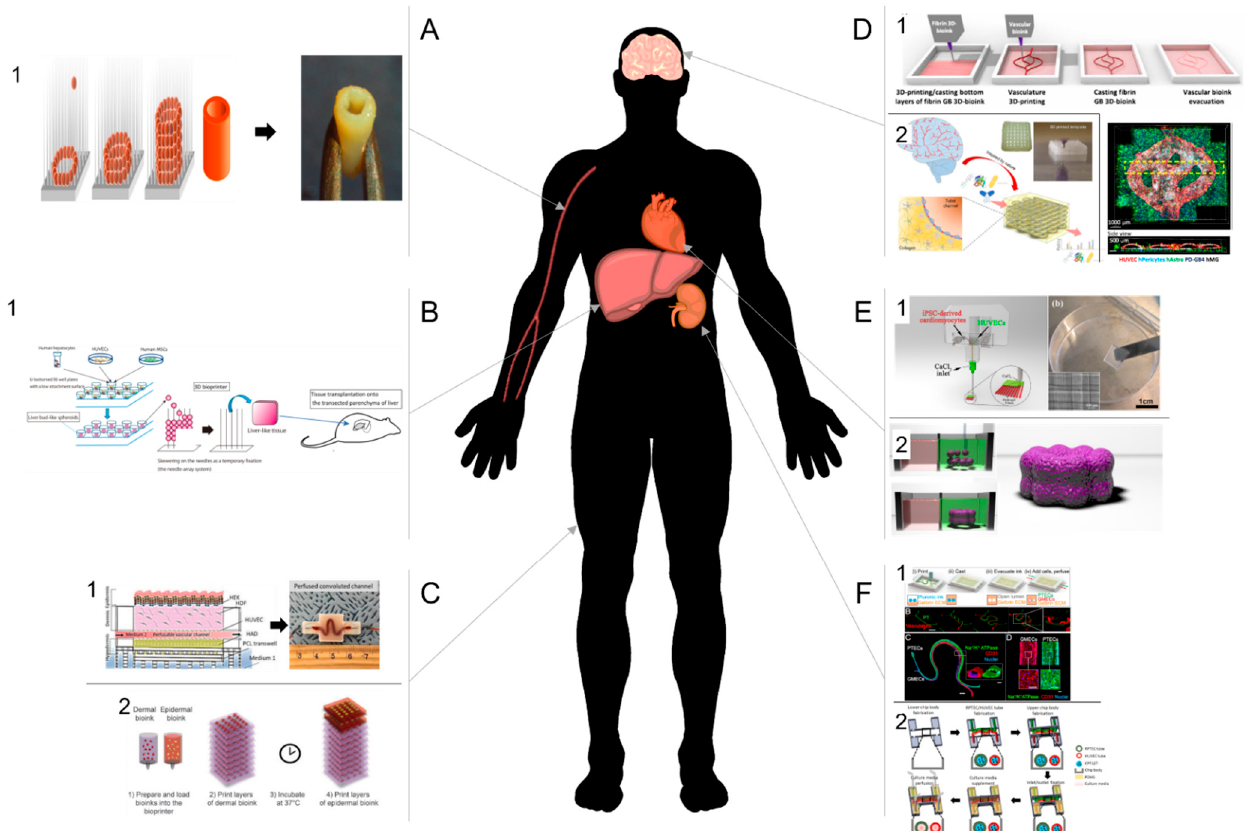
Figure 4. 3D bioprinted scaffold for tissue vascularization ( A ) or vascularized tissues ( B – F ). ( A ) Cardiovascular system. (1) A tubular tissue was printed from multicellular spheroids (MCS) using needle array bioprinting system (left). After fusion of the spheroids, the tubular structure can be removed from the needle array and used as a blood vessel [43]. ( B ) Liver. (1) A liver-like tissue was constructed from liver bud-like spheroids composed of hepatocytes, mesenchymal stem cells, and endothelial cells, on a needle array. After fusion of the spheroids, the tissue was removed and implanted onto the transected parenchyma of mouse liver [134]. ( C ) Skin. (1) Schematic representation (left) of a bioprinted perfusable vascularized human skin tissue composed of a hypodermal pre-adipocyte compartment containing the vascular channel and covered with a dermal layer and topped with printed primary human epidermal keratinocytes. Pictures of the perfused tissue (right) [144]. (2) Schematic representation of a bioprinted human skin equivalent composed of multiple dermal layers (dermal bioink) and two epidermal layers (keratinocytes bioink) [143]. ( D ) Brain. (1) Schematic representation of the printing process for the